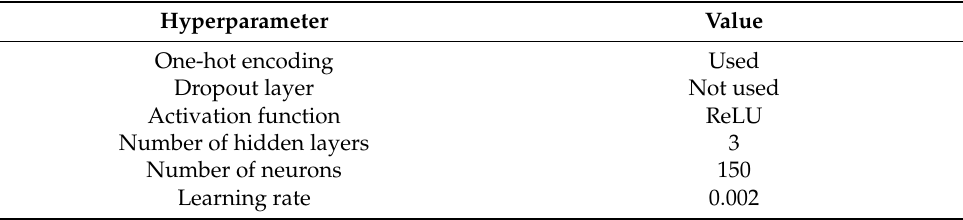
Table 9. Hyperparameter results of DNN model selected through sensitivity analysis.